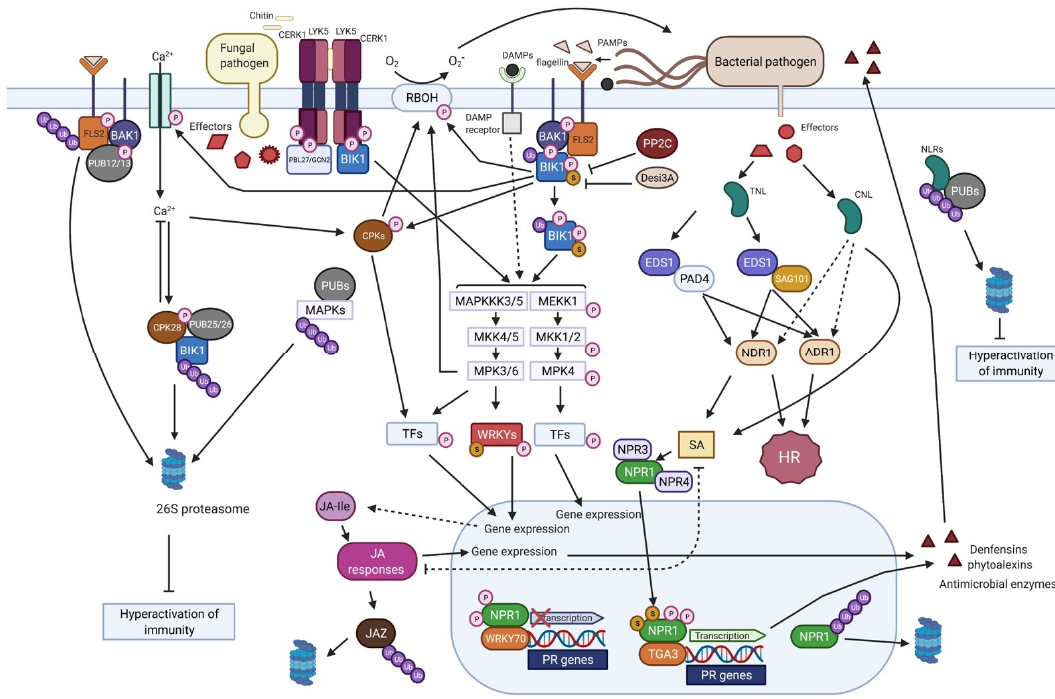
Figure 1. The framework of plant immunity. Briefly, microbe-derived pathogen-associated molecular patterns (PAMPs) and host damaged-associated molecular patterns (DAMPs) are perceived by cell-surface pattern recognition receptors (PRRs), which along with coreceptors activate downstream phosphorylation cascades and induce increased [Ca 2+ ] and reactive oxygen species (ROS) accumulation. ROS can act as second messengers to cause stomatal closure and directly have antimicrobial effects. Pathogen effectors are perceived by intracellular receptors, NUCLEOTIDE BINDING SITE- LEUCINE-RICH-REPEAT (NLRs also known as NB-LRRs), which activate downstream responses including Salicylic acid (SA)accumulation. SA and Jasmonic Acid (JA) accumulate in response to pathogens and largely work antagonistically to biotrophic and necrotrophic pathogens, respectively. Outcomes of defence signalling include changes to gene expression, production of (PR) proteins, and biosynthesis of antimicrobial metabolites. Post-translational modifications (PTMs) are involved in all aspects of plant immunity controlling activation, protein interactions, subcellular localisation, and protein turnover. Further details in the main text. P, phosphate group. S, SUMO. Ub, Ubiquitin. Solid lines indicate direct interac- tions, dashed lines indicate indirection interactions. FLS2, FLAGELLIN-SENSING 2; BAK1, BRI1-ASSOCIATED RECEPTOR KINASE; BIK1, BOTRYTIS-INDUCED KINASE 1; EDS1, ENHANCED DISEASE SUSCEPTIBILITY 1; CERK1, CHITIN ELICITOR RECEPTOR KINASE 1; LYK5, LYSM-CONTAINING RECEPTOR-LIKE KINASE 5; NPR, NONEXPRESSOR OF PATHOGENESIS-RELATED GENES; TGA3, TGA 1a-related gene; CPK, CALCIUM-DEPENDENT PROTEIN KINASES; NDR1, NON-RACE-SPECIFIC DISEASE RESISTANCE 1; ADR1, ACTIVATED DISEASE RESISTANCE 1; PAD4,